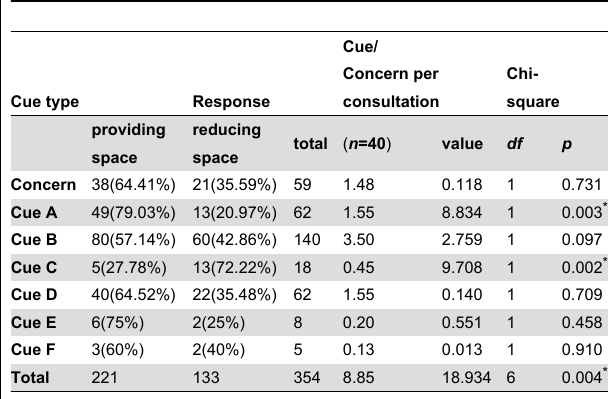
Table 3. Frequency of cues of concerns and